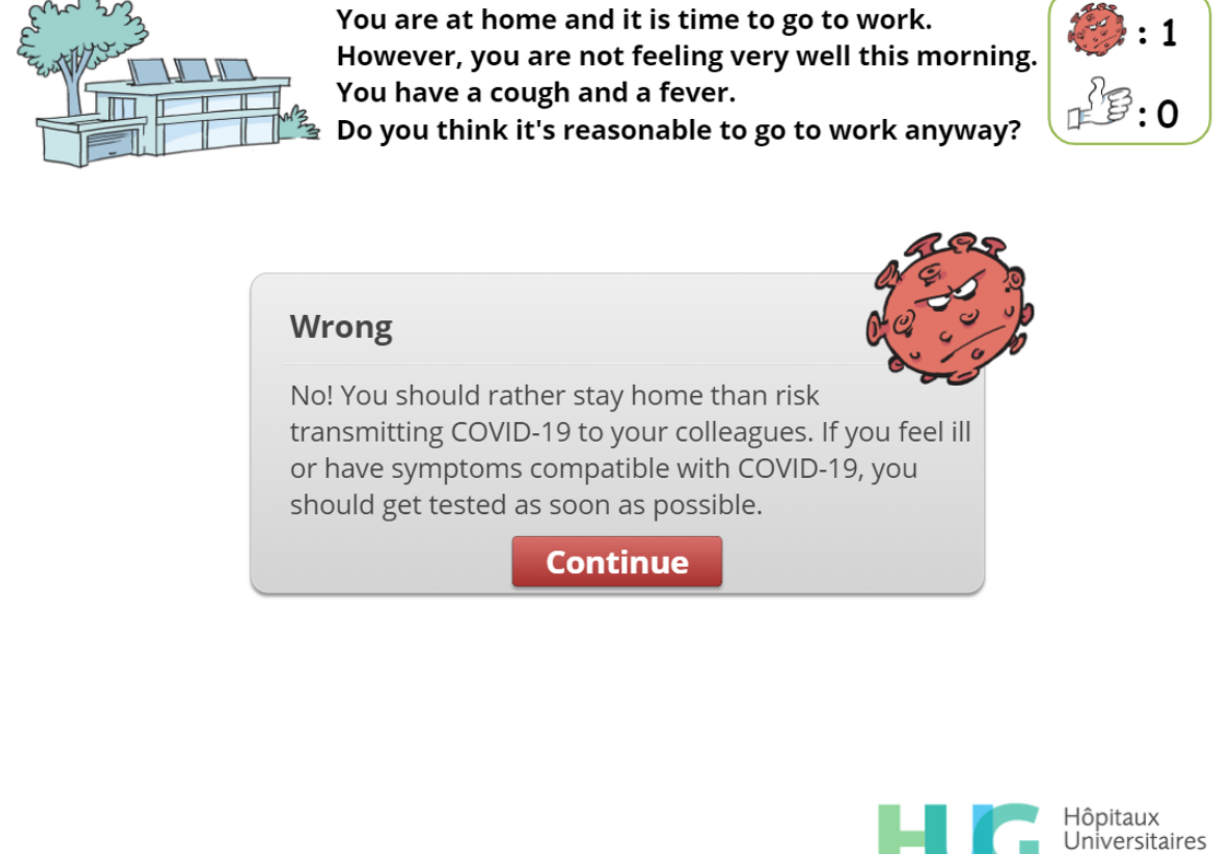
Figure 8. Feedback. The player has chosen to go to work despite the symptoms and is now told they should have undergone a test to screen for SARS-CoV-2 infection. The virus count (top right) has increased